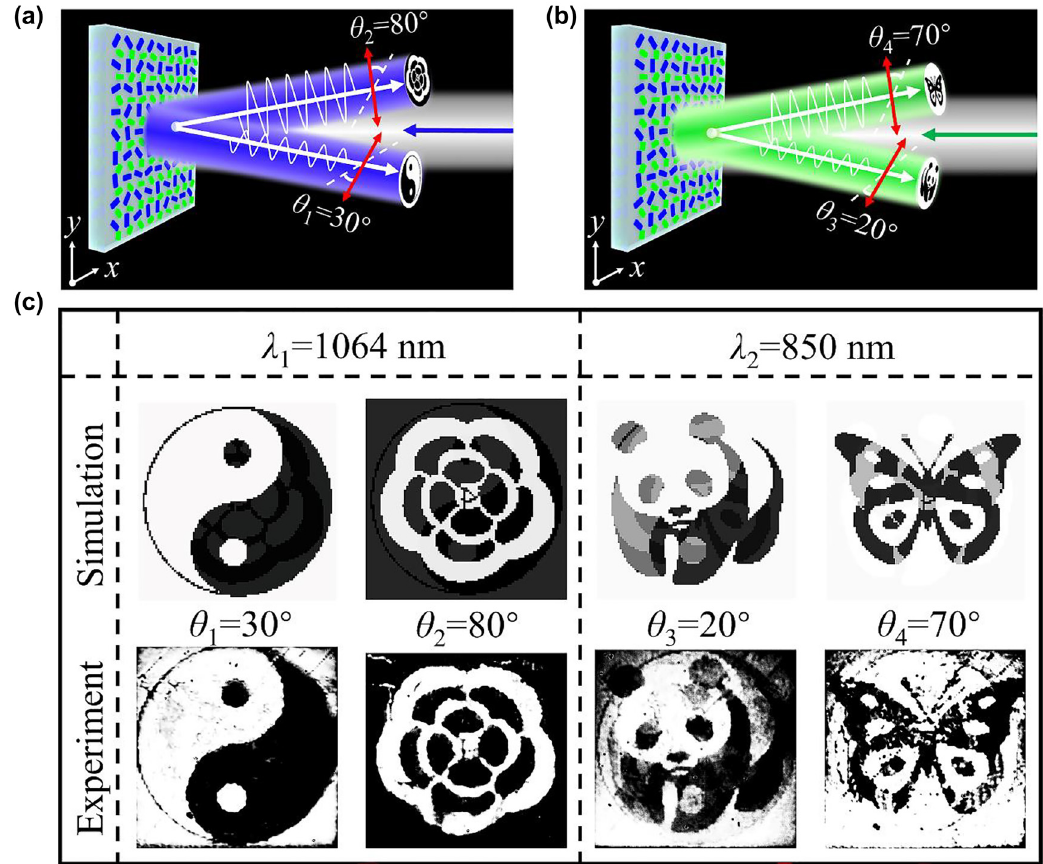
Figure 6: Schematic and characterization of four-channel display